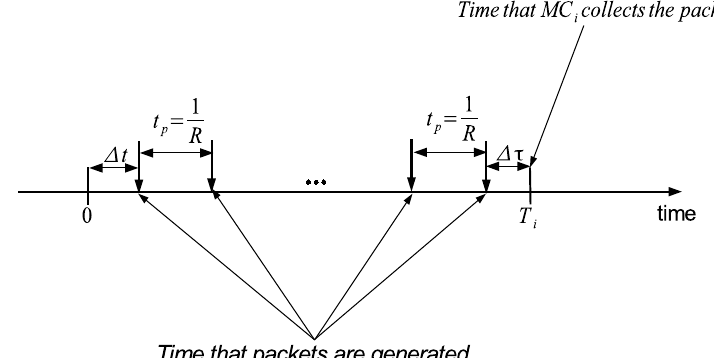
Figure 5. Estimation of the average waiting time of a packet in the